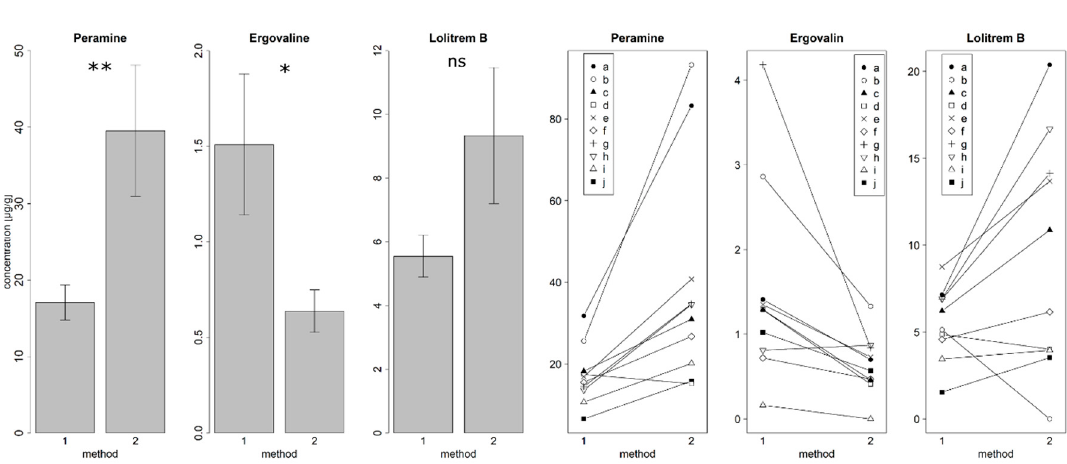
Figure 3. a: Comparison of alkaloid concentrations [µg/g DW] (peramine, ergovaline, and lolitrem B, mean ± SE) detected with the UPLC method from this study (method 1) and the UPLC method from [36] (method 2). Peramine: n = 10, p = 0.008 **, ergovaline: n = 9, p = 0.02 *, and lolitrem B: n = 10, p = 0.052, not significant). b: Comparison of alkaloid concentrations [ µ g / g] (peramine, ergovaline, and lolitrem B) of single samples ( a – j ) detected with the UPLC method from this study (method 1) and the UPLC method from [36] (method 2).